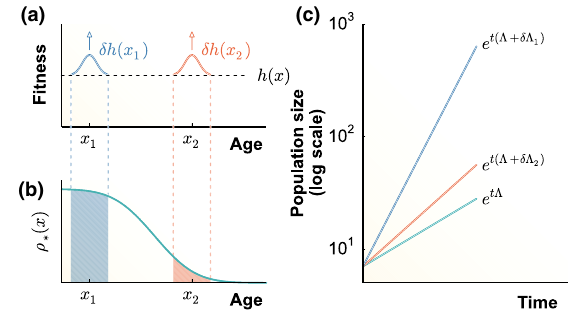
FIG. 1. Strength of selection on life-history traits and the optimal lineage relation. (a) A behavioral change (e.g., a mutation, an epigenetic modification, or a different survival strategy) causes a small fitness increase δ h in a life-history trait h ð x Þ for cells at ages x x 1 and 2 . (b) After a sufficiently long time, a population reaches steady-state growth and the population dynamics are dominated by cells whose ancestral lineage has an optimal age distribution ρ (cid:2) ð x Þ . The distribution ρ (cid:2) determines what portion of lineages benefit from the small boosts in fitness at ages x 1 and x 2 : the change in growth rate δ Λ resulting from the boost in fitness at age x i is precisely equal to δ h · ρ (cid:2) evaluated at x x i . (c) In this example, the change in growth rate is larger at age 1 because it affects a larger fraction of the population ’ s lineage